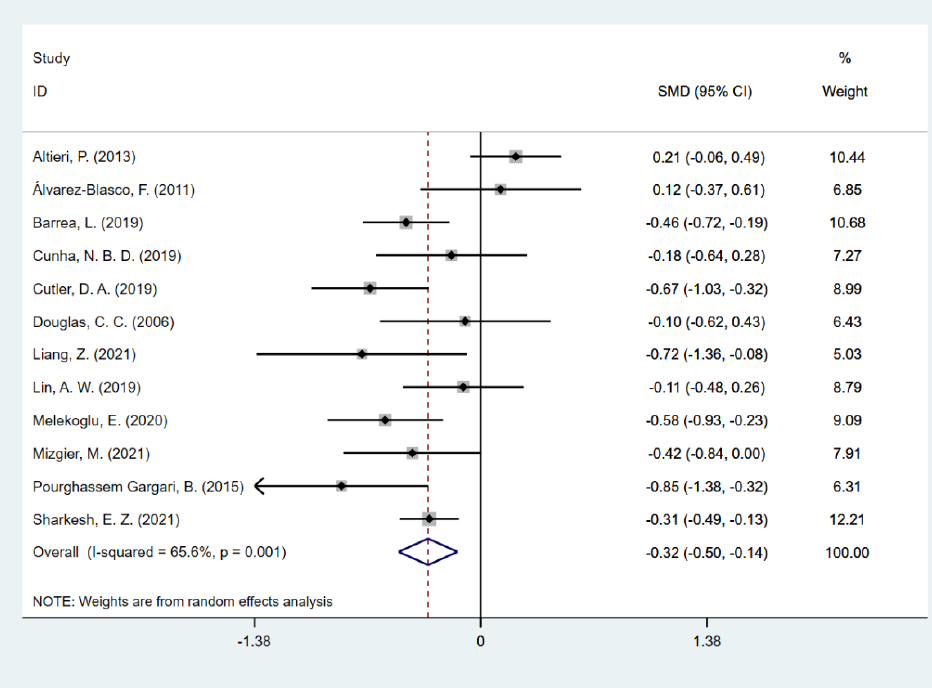
Figure 2. Meta-analysis of daily dietary fiber intake on studies unadjusted for total energy intake [38−40,42−50].